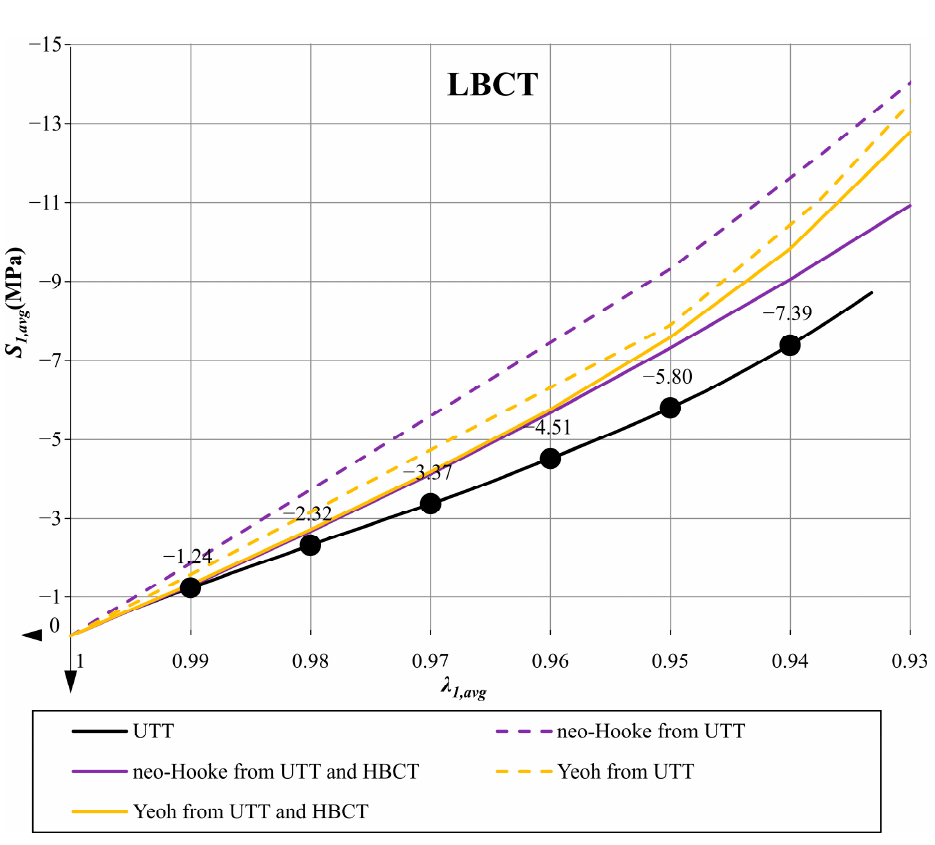
Figure 10. Normalized mean squared error for low bearing compression test with successive sets of material parameters.